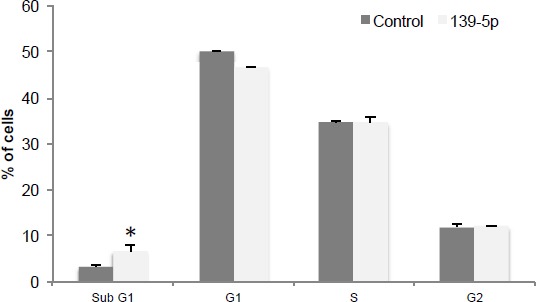
miR-139-5p induces apoptosis.H460 cells were transfected with pSIF-H1-Scramble control (Control) or pSIF-H1-miR-139-5p (139-5p), and 48 hr after transfection, the cells were subjected to flow cytometry analysis. *p<0.05. Error bars, SD.